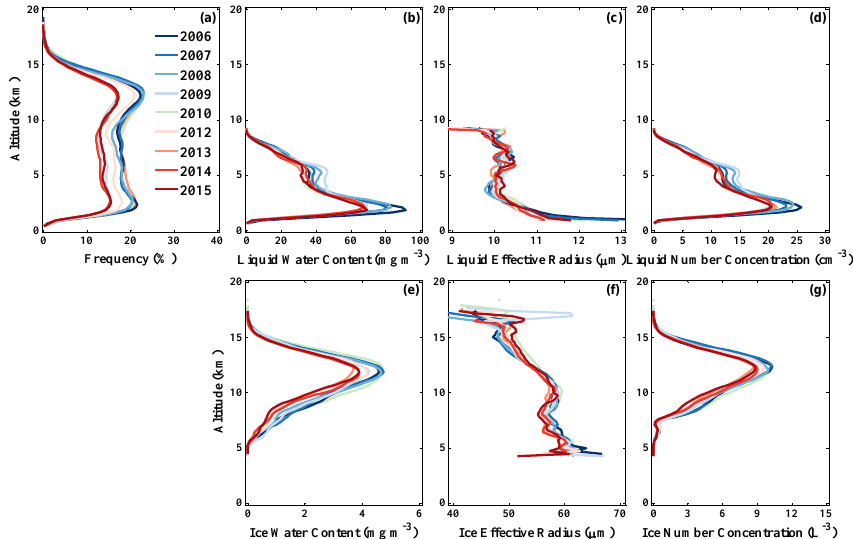
Figure 2. Temporal variations in spatial average vertical cloud physical parameters from CloudSat during the monsoon season in South Asia from 2006 to 2015: ( a ) cloud vertical frequency distribution, and liquid and ice ( b , e ) water content, ( c , f ) effective radius, and ( d , g ) number concentration.